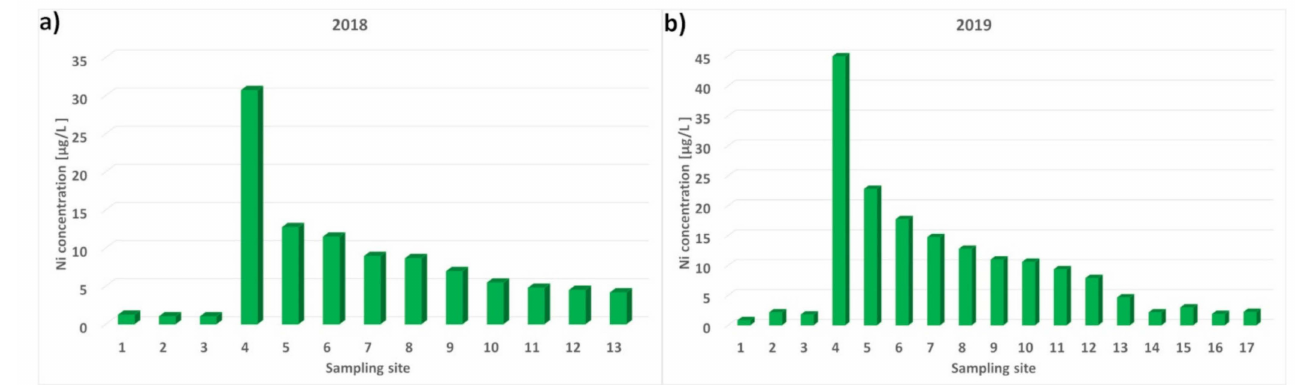
Figure 2. Median values of Ni concentrations in 2018 ( a ) and 2019 ( b ) for individual sampling sites, respectively. Other anthropogenically impacted rivers showed different spatial tendencies